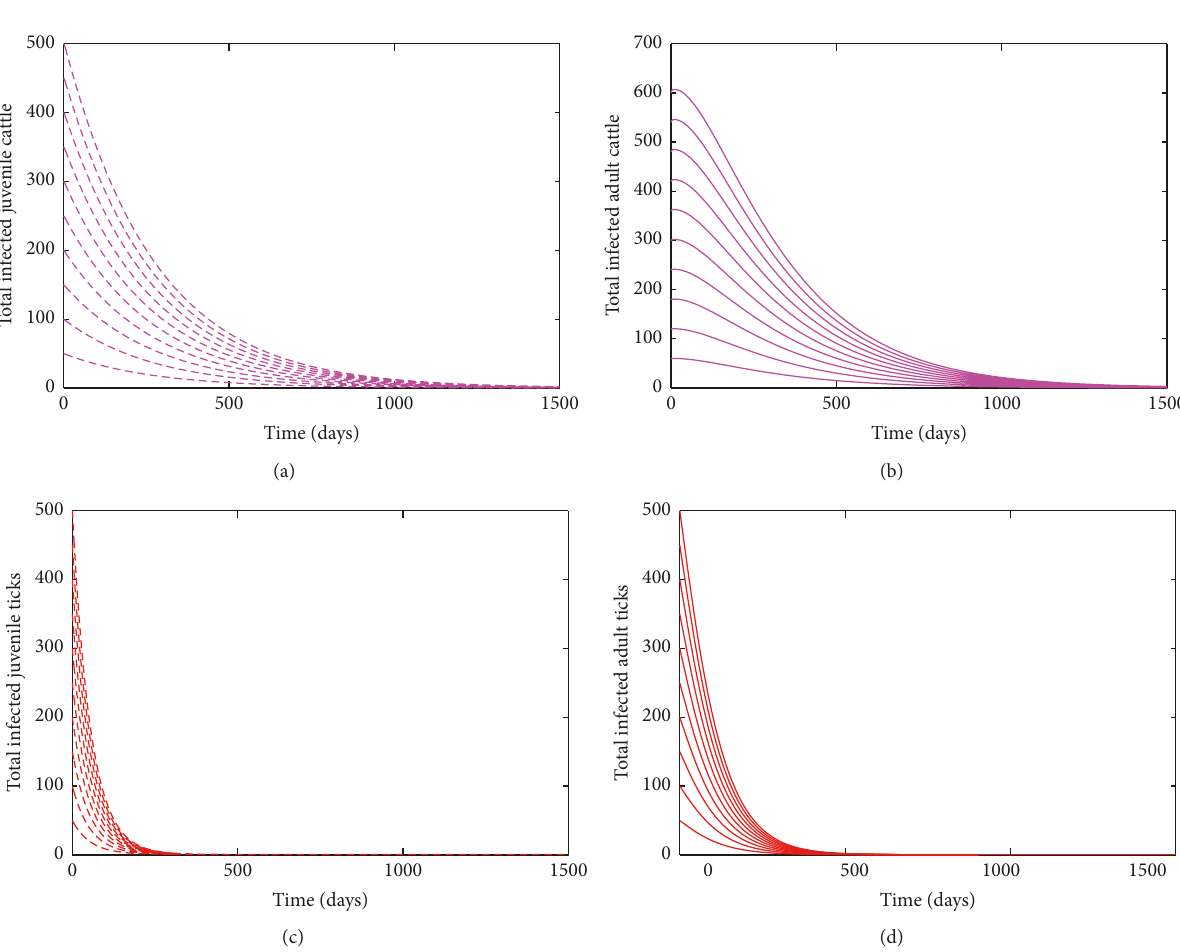
Figure 2: Simulation of the bovine anaplasmosis model (12) for different initial conditions as a function of time when R 0 < 1 . The different initial conditions converges to the disease-free equilibrium when R 0 < 1 . (a) Total number of infected (asymptomatic and carrier) juvenile cattle. (b) Total number of infected (asymptomatic and symptomatic) adult cattle. (c) Total number of infected juvenile ticks. (d) Total number of infected adult ticks. Parameter values used are as given in Table